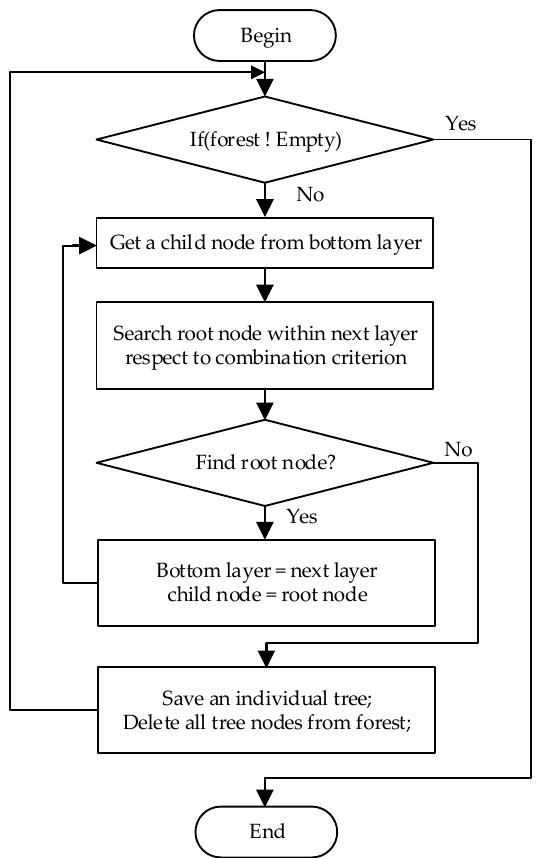
Figure 9. Flow chart of cross-layer combination.